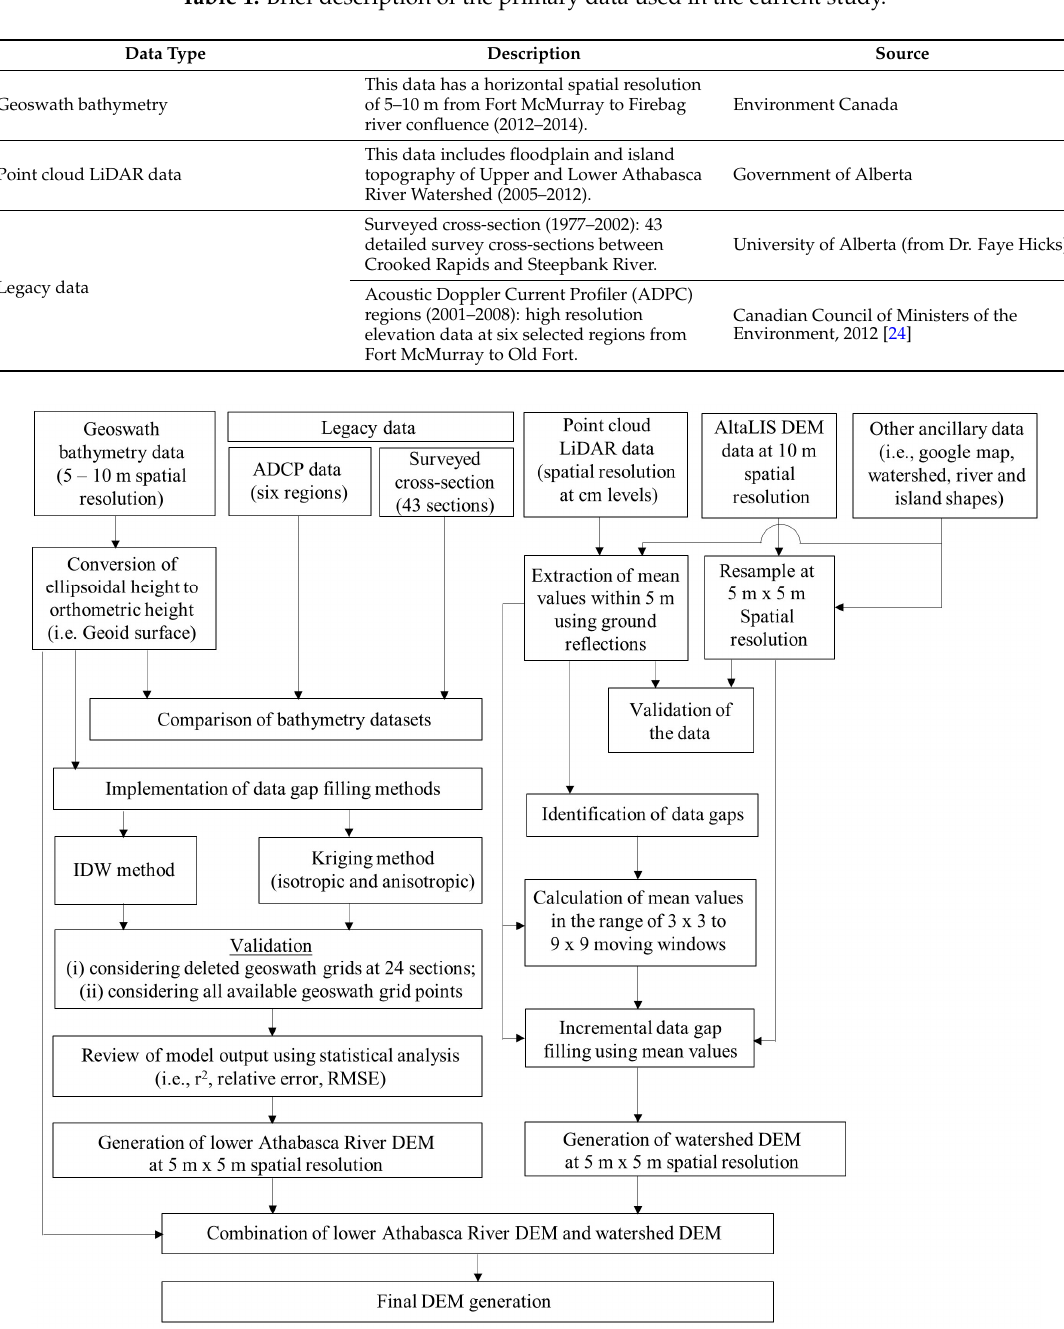
Figure 2. The conceptual diagram of gap filling methods and generation of lower Athabasca River watershed DEM.